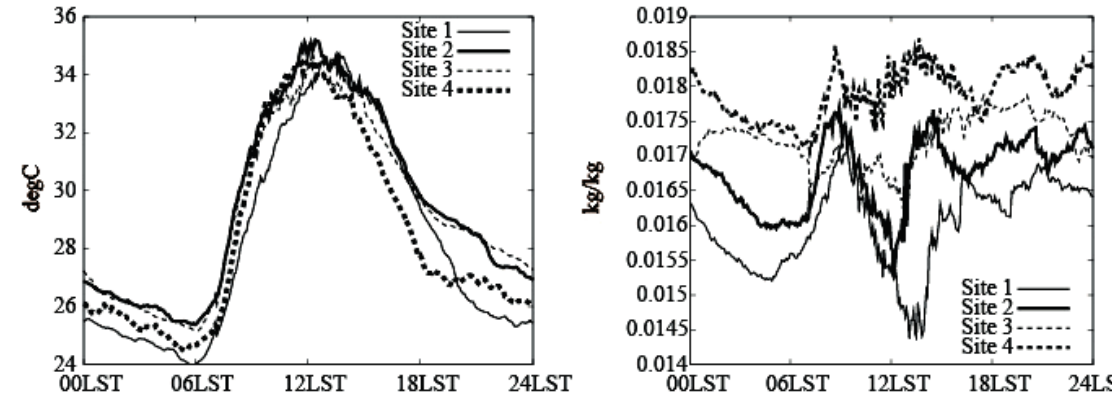
Fig. 6 Observed temperature (left) and specific humidity (right) averaged on dry season sunny days (16, 19, 22, 26, 27, 28